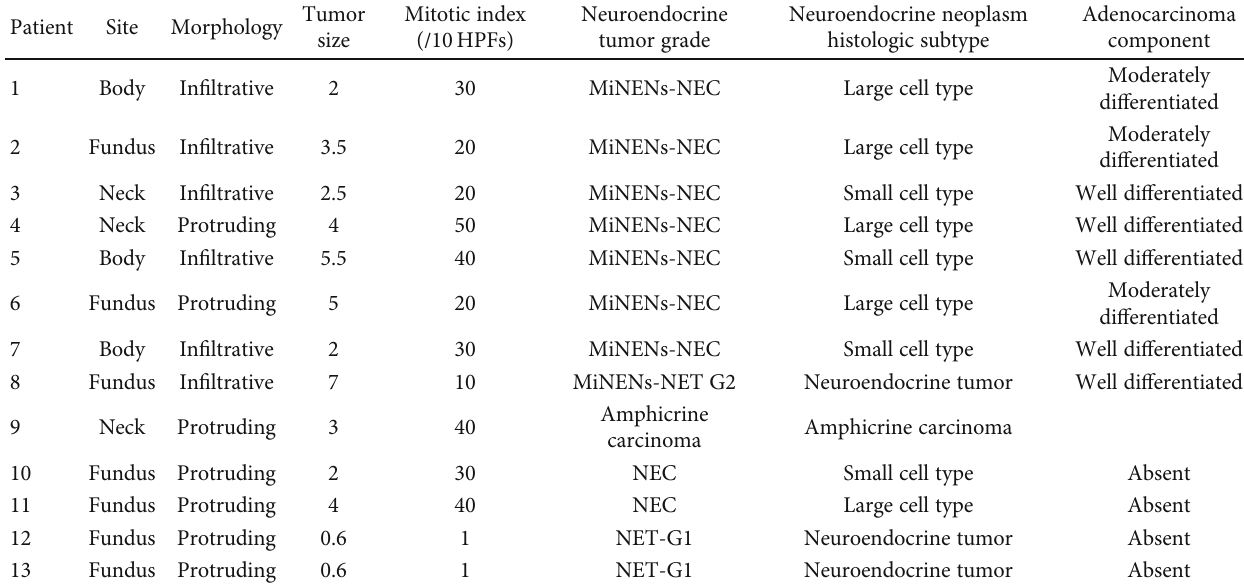
Table 2: Pathology of 13 patients with GB-NENs.